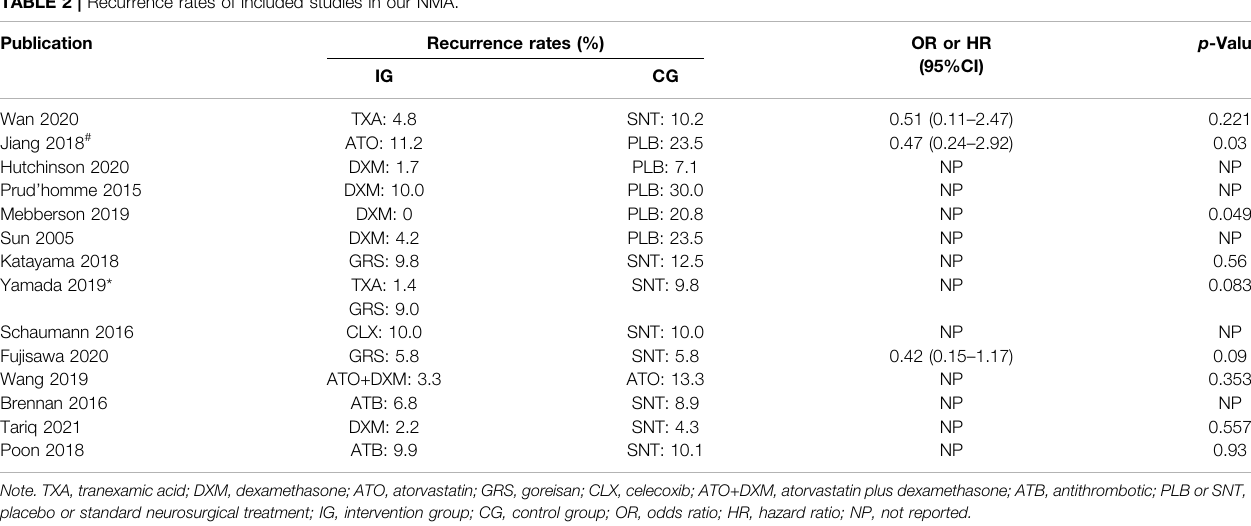
TABLE 2 | Recurrence rates of included studies in our NMA.